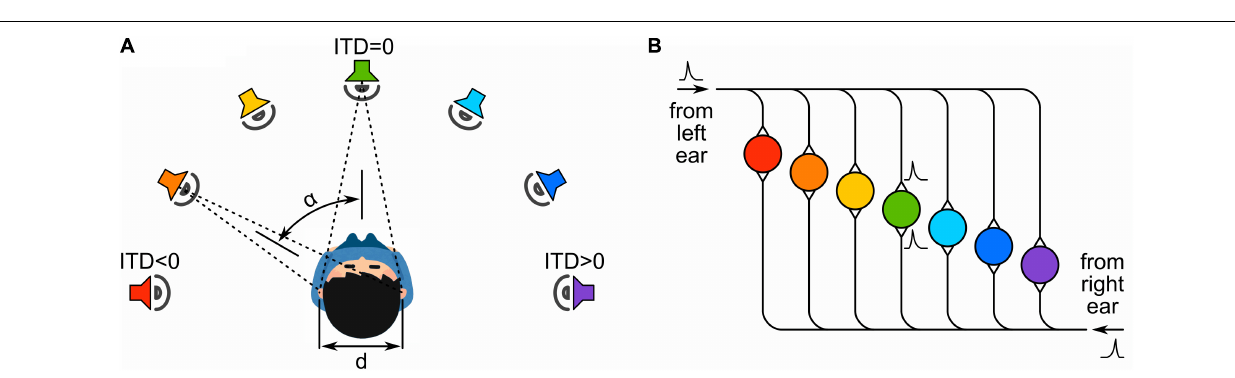
FIGURE 2 | (A) The sound is incident with an angle α on the azimuthal plane that is transduced into an interaural time difference (ITD) for the excitation of the left and right ears auditory system. (B) The system generates spikes at the L and R input neurons that propagate down their respective long axons (delay lines). The ITD is mapped onto the position of output neurons that detect the coincidence of spikes propagating down the long axons. Two spikes arriving in coincidence to the green neuron when α = 0 and ITD =